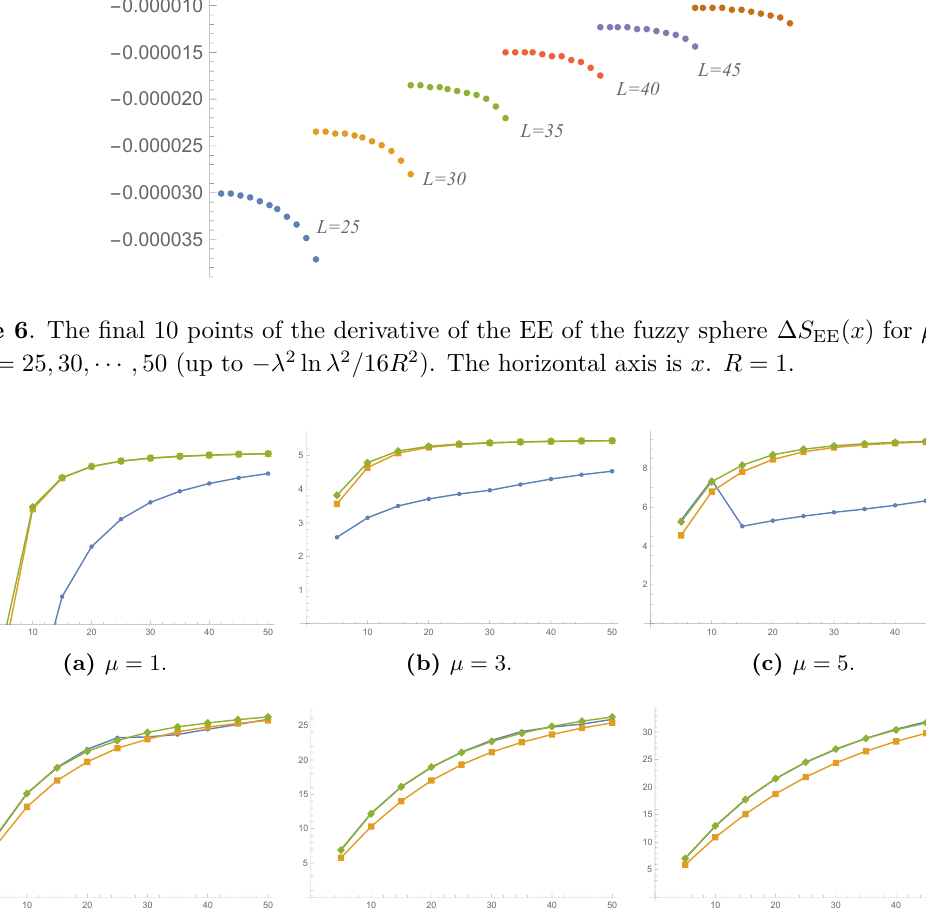
and the horizontal axis is peak